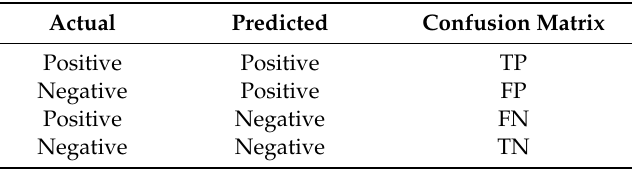
Table 6. The confusion matrix